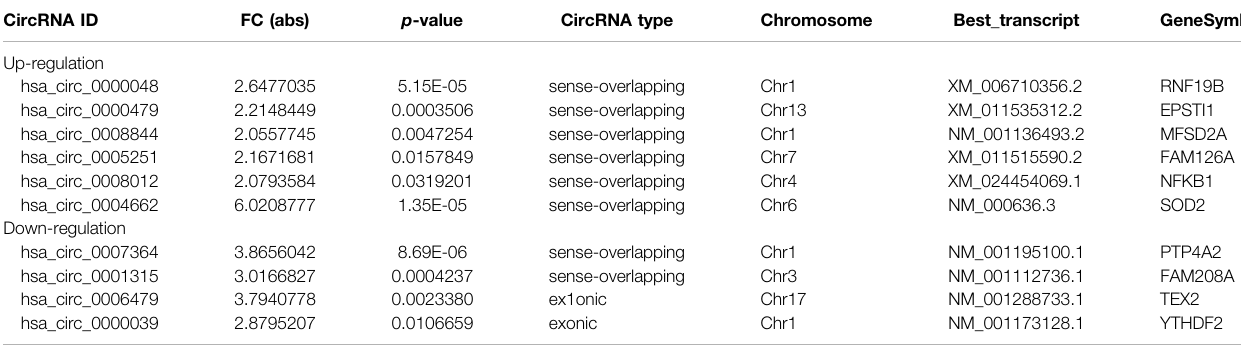
TABLE 1 | Biological information regarding the 6 up- and 4 down-circRNAs in M1